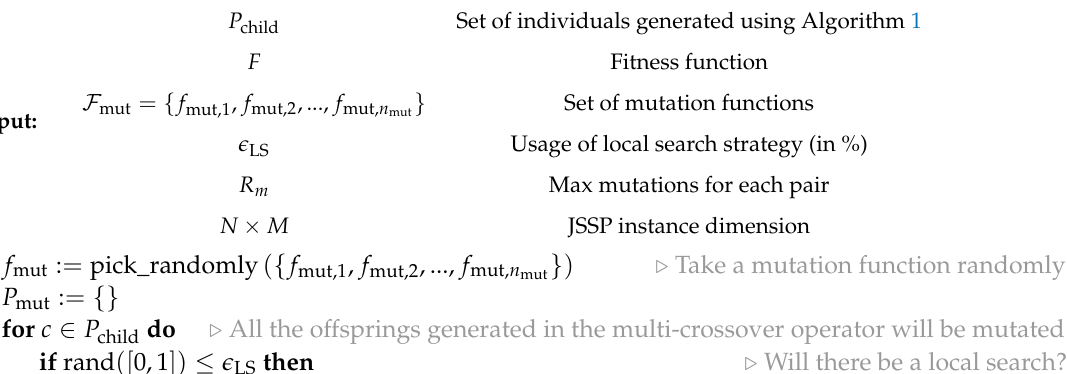
Algorithm 2 Proposed mutation